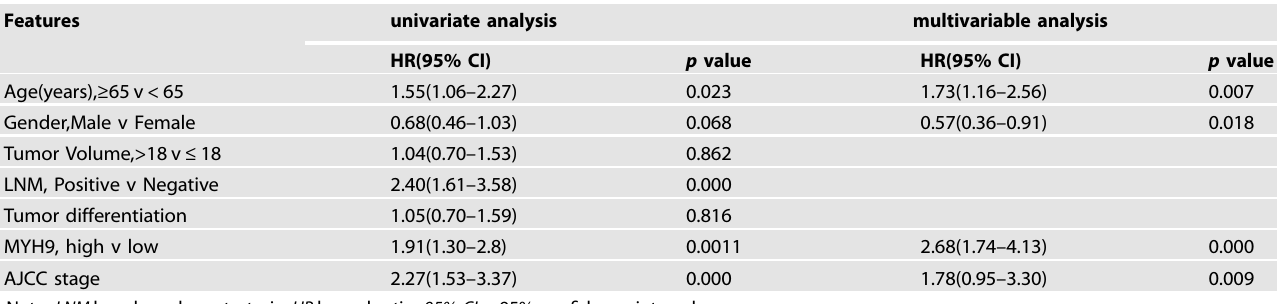
Table 1. Univariate and multivariate regression analysis of prognosis in patients with NSCLC.